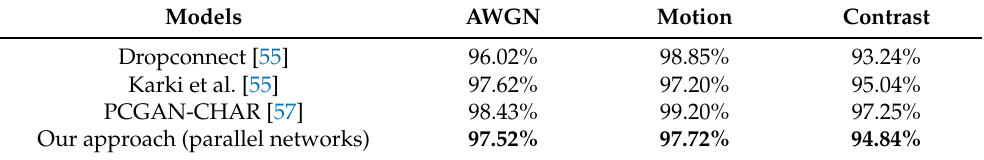
Table 7. Comparison of the classification accuracy on the three versions of the Noisy MNIST Dataset.